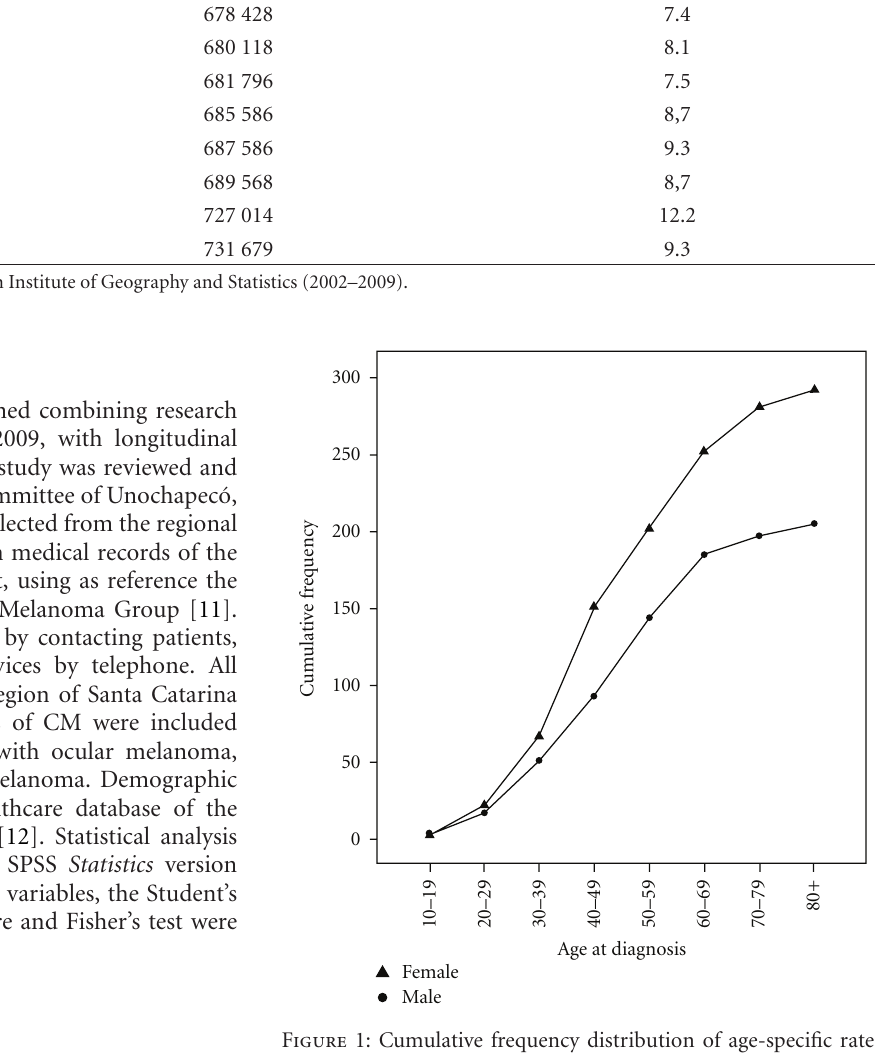
Table 1: Number of cases per year and incidence of cutaneous melanoma in the west of Santa Catarina, Brazil ( n = 497). Year